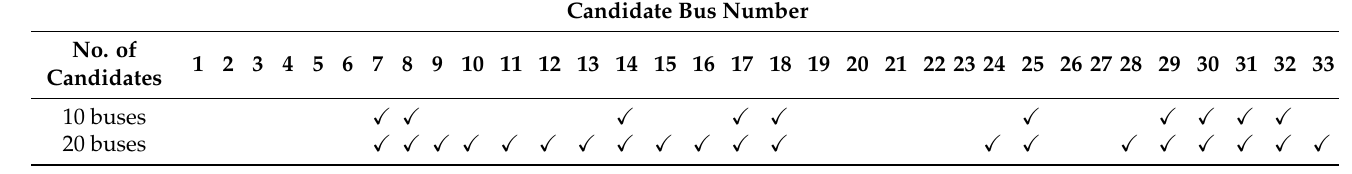
Table 3. Type-2 most effective buses.